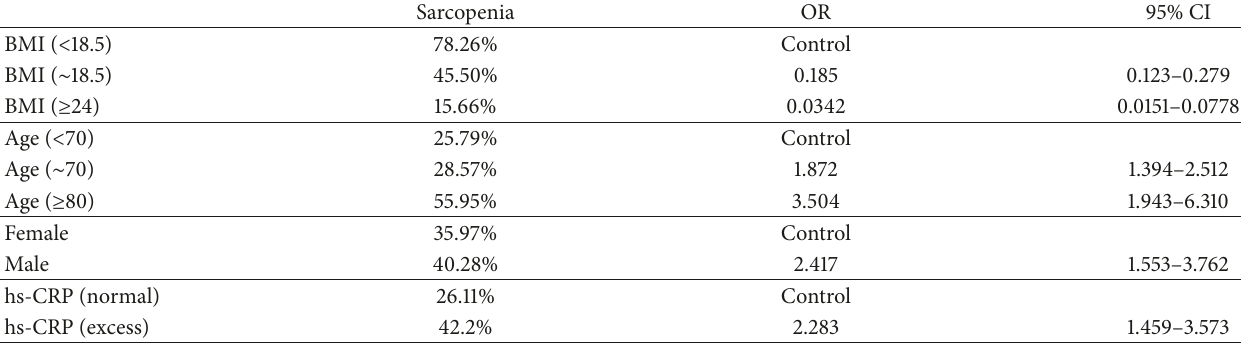
Table 3: Logistic regression analysis of the association between sarcopenia and NAFLD, BMI, age, sex, and